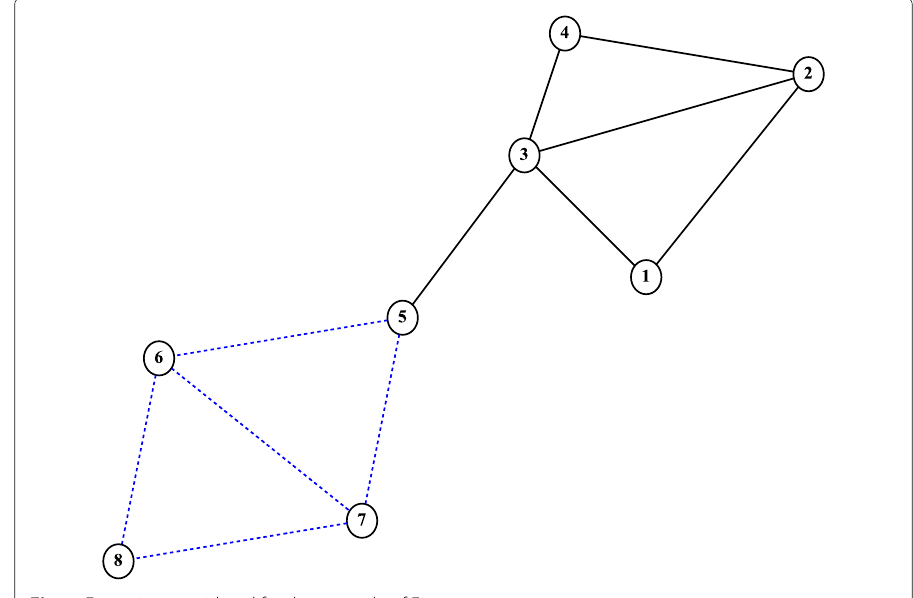
Fig. 4 Extension considered for the example of Fig.